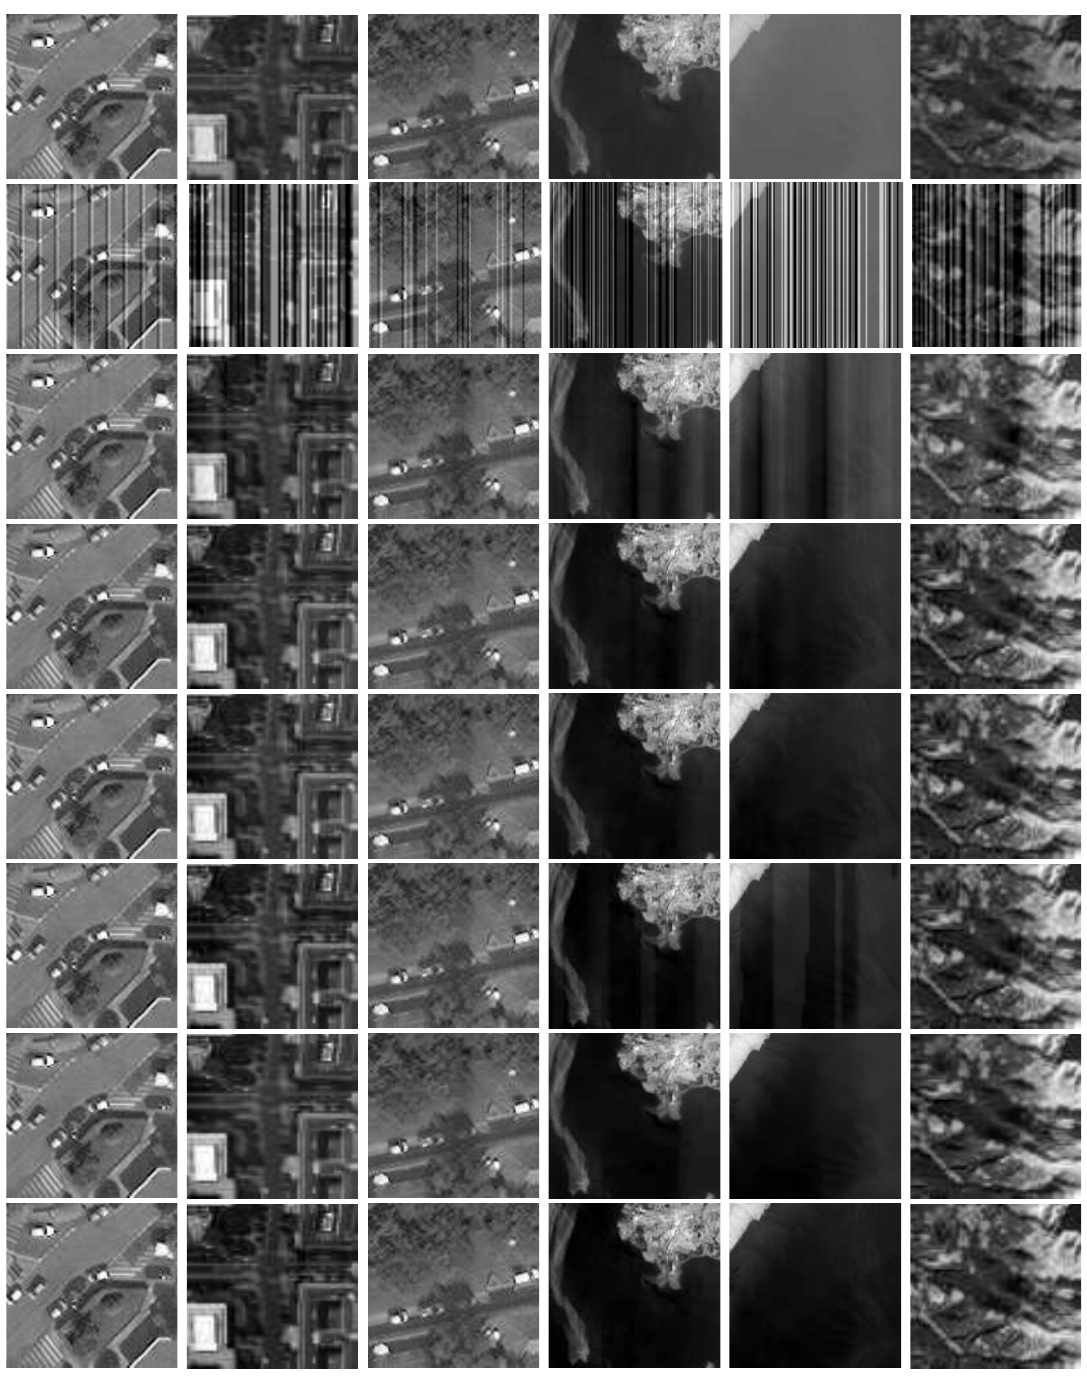
Figure 4. The zoom results of different simulated images in Figure 3. From top to bottom: zoom of the underlying images, the degraded images, the destriping results of WFAF, SLD, UTV, GSLV, LRSID, and Ours. Note that the levels of stripes are same as Figure